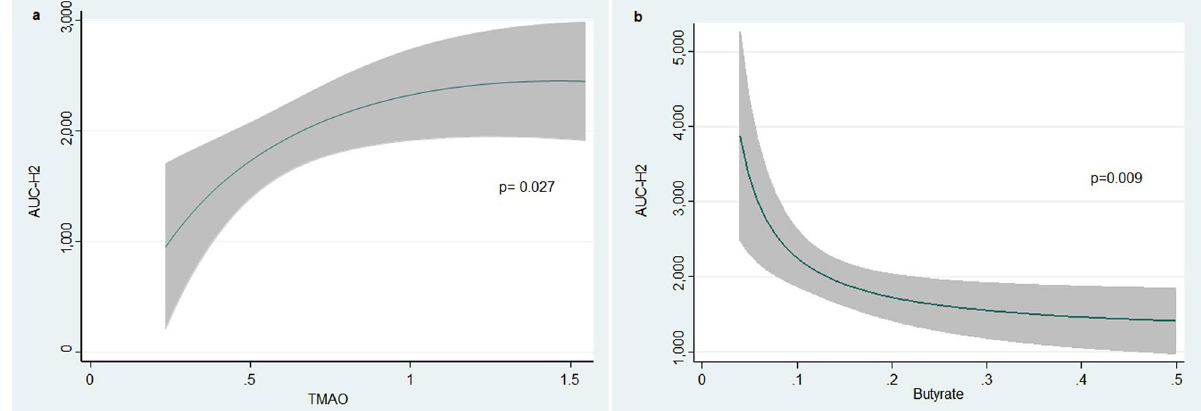
Figure 1. Multivariate association between AUC-H2 and blood bacterial metabolites (TMAO and Butyrate). TMAO Trimethylamine N-oxide, AUC-H2 Area under the curve of hydrogen concentration.